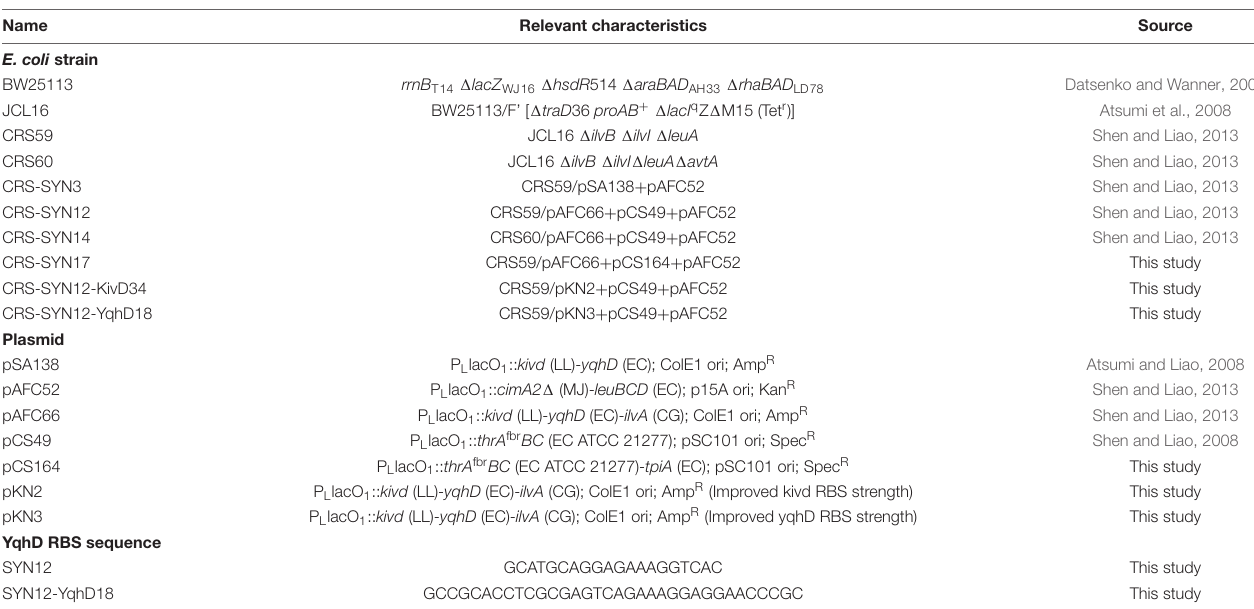
FIGURE 1 | Illustration of the keto-acid pathway for 1-propanol synthesis. Schematic illustration of the threonine pathway (denoted by the green arrow) and the citramalate pathway (denoted by the blue arrow) for the synthesis of 1-propanol in E. coli from glucose as previously described in Shen and Liao (2013). Genes not overexpressed are noted in gray font. Cross mark indicates that the pathway was blocked via gene deletion. The deleted gene encode for 2-isopropylmalate synthase ( leuA ). PEP, phosphoenolpyruvate; cimA, citramalate synthase from Methanococcus jannaschii (MJ); KivD, alpha-ketoisovalerate decarboxylase from Lactococcus lactis (LL); YqhD, alcohol dehydrogenase from Escherichia coli (EC). TABLE 1 | Strains and plasmids used in this